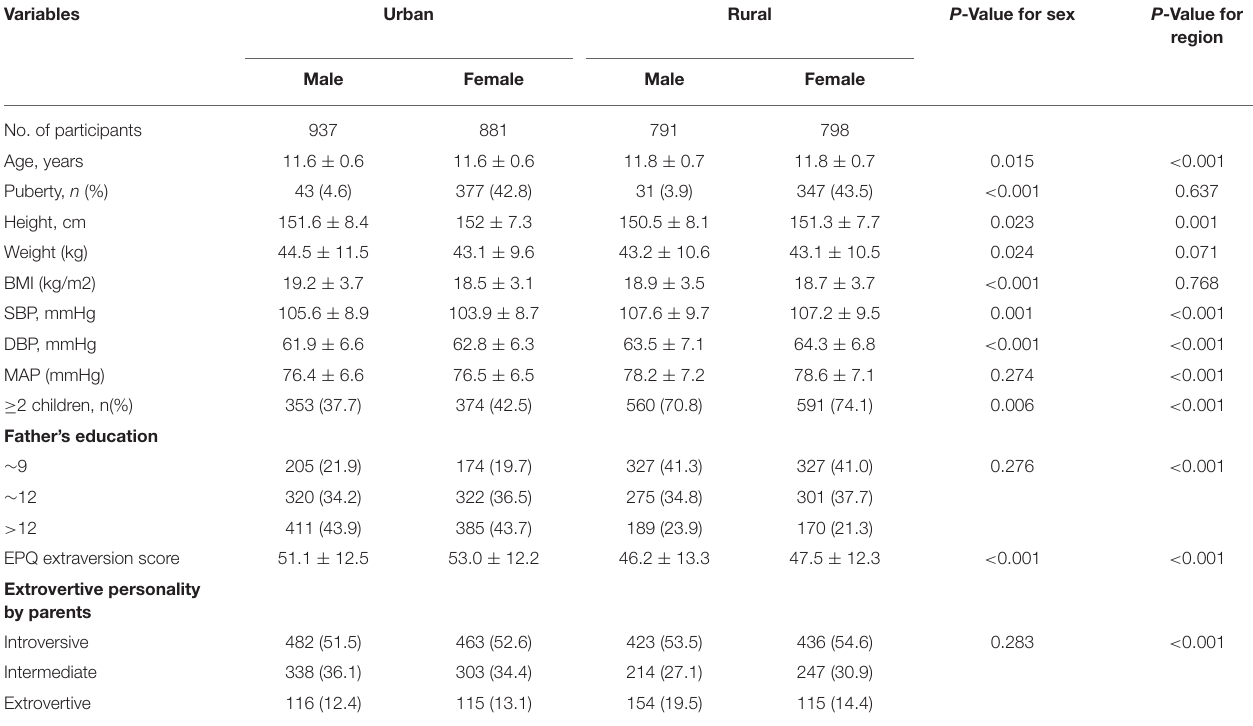
TABLE 1 | Participants’